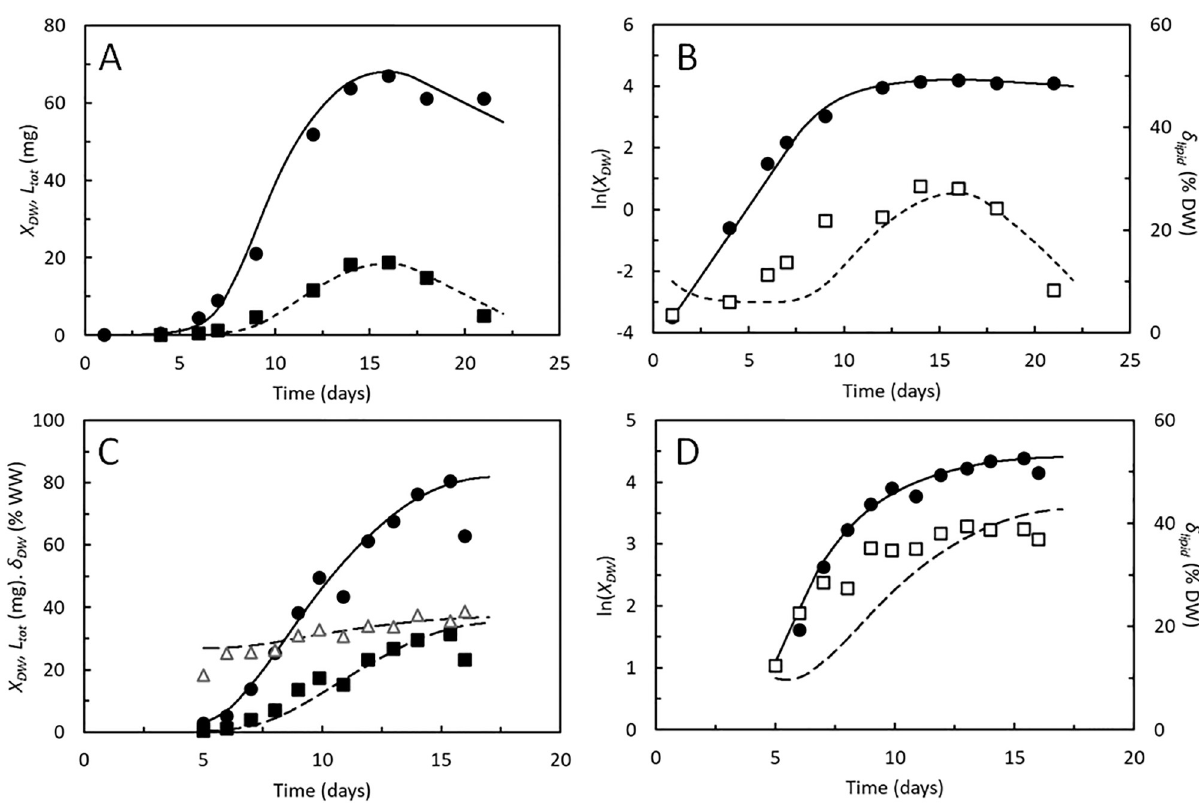
Fig 3. Hermetia illucens . A and C. Dry weight, X chicken feed. B and D. Logarithmic transformed dry weight ( ● ) and lipid to dry weight ratio, δ lipid ( □ ) of the BSF larvae. Data points from 2 independent studies [21, 22]. Curves predicted by the growth model. Parameters shown in Table